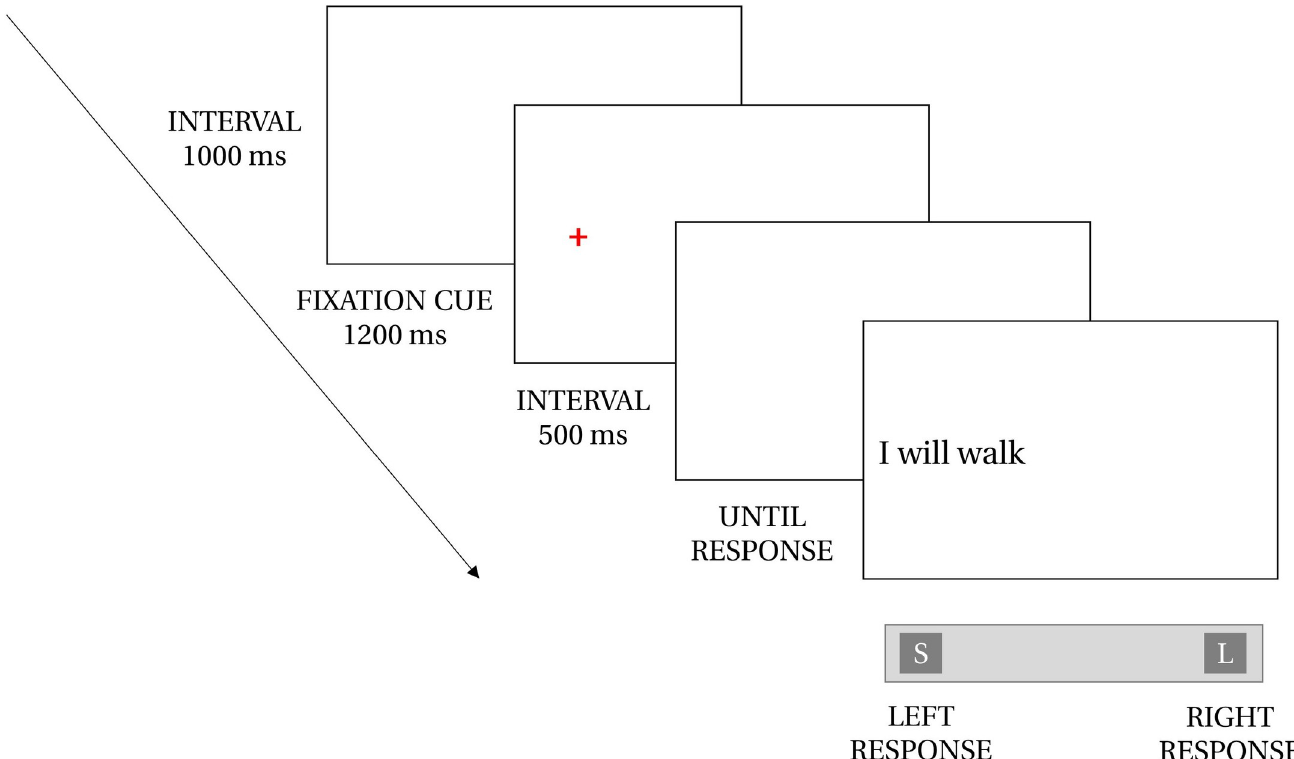
Fig 1. Experimental design. Words were displayed after a spatial fixation cue. Participants made their temporal categorization by pressing the left or the right response key (i.e., “S” and “L” key) on an AZERTY keyboard.